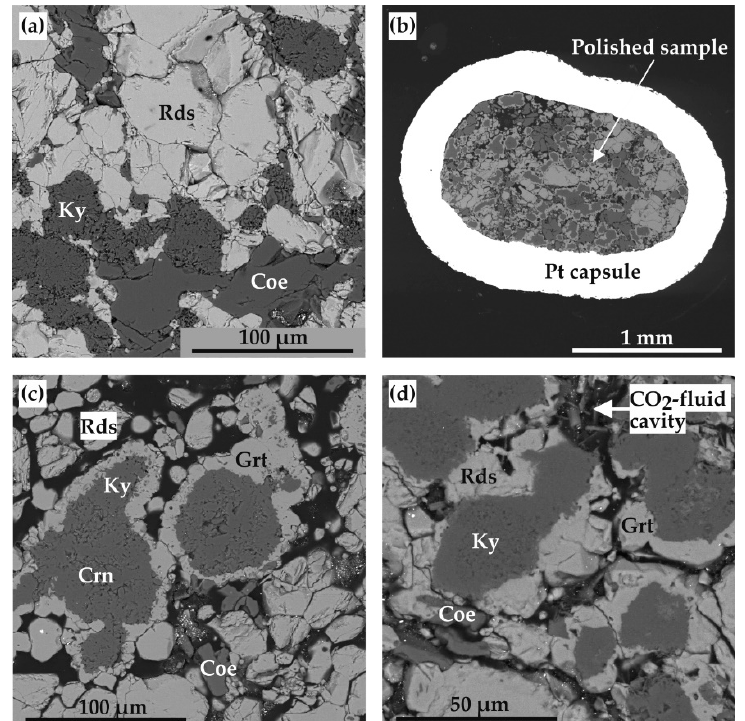
Figure 3. SEM micrographs of polished fragments of samples obtained in the MnCO 3 -SiO 2 -Al 2 O 3 system: ( a ) polycrystalline aggregate of newly formed kyanite and recrystallized coesite and rhodochrosite (run N 2129-R, 6.3 GPa, 1050 ° С ); ( b ) a platinum ampoule with a sample (run N 2117- R, 6.3 GPa, 1100 °C); ( c ) polycrystalline aggregate of newly formed spessartine and kyanite and recrystallized initial oxides and rhodochrosite (run N 2117-R, 6.3 GPa, 1100 °C); ( d ) polycrystalline aggregate of spessartine, mullite, , and recrystallized coesite, with CO 2 -fluid cavities (run N 2130-R, 6.3 GPa, 1100 °C); Grt—spessartine garnet, Coe—coesite, Crn—corundum, Ky—kyanite, Rds— rhodochrosite.